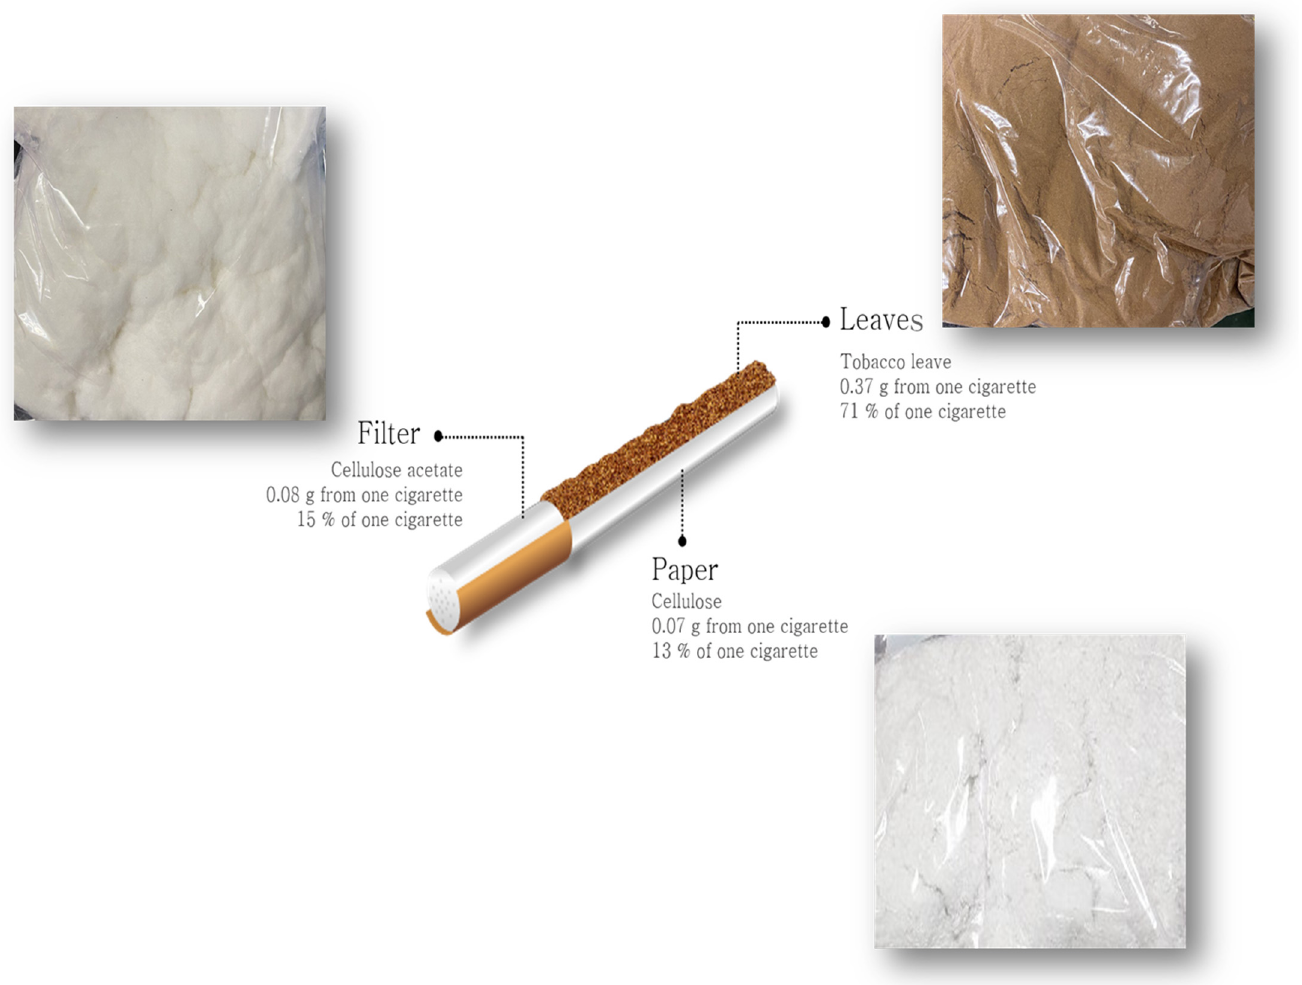
Figure 1. Cigarette composition used for anaerobic digestion. The inserted pictures show the powder after the chopping process.